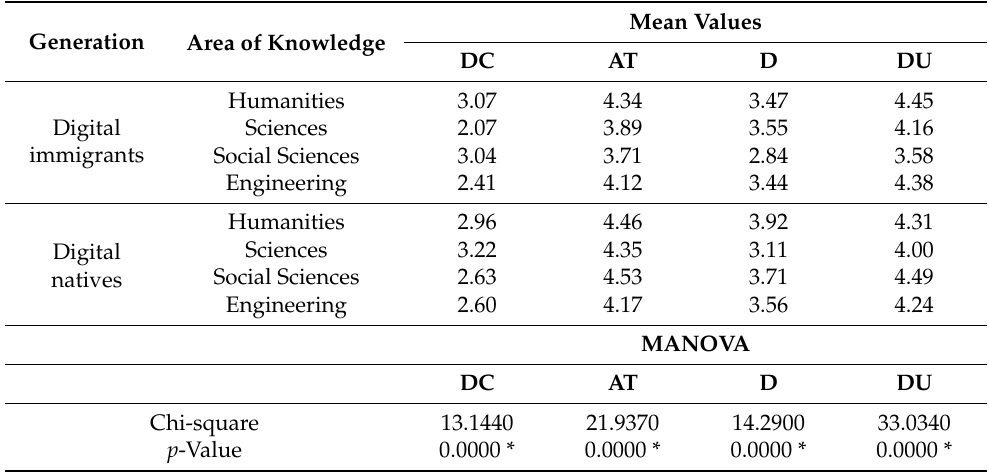
Table 11. Mean answers (out of 5) and MANOVA test statistics when participants are differentiated by area of knowledge and digital generation.